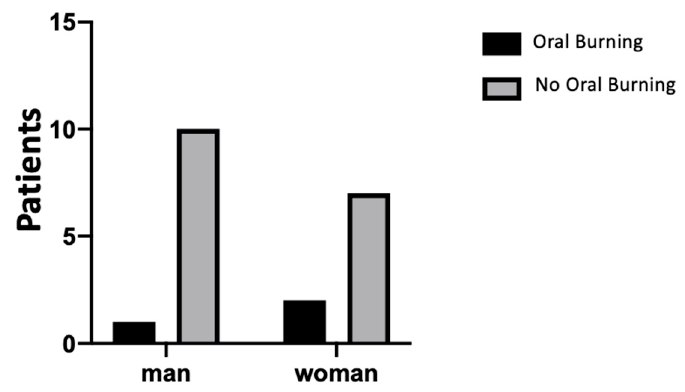
Figure A9. Difference between oral burning sensation between males and females. No statistical significance ( p = 0.56) was shown between the sexes.